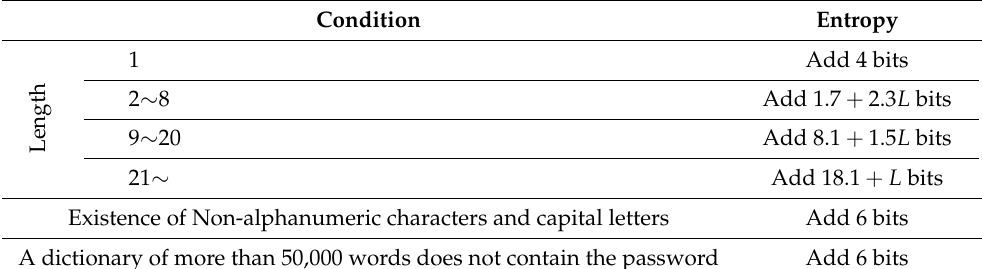
Table 1. Entropy assigning rules in NIST meter [5] ( L : the length of password).